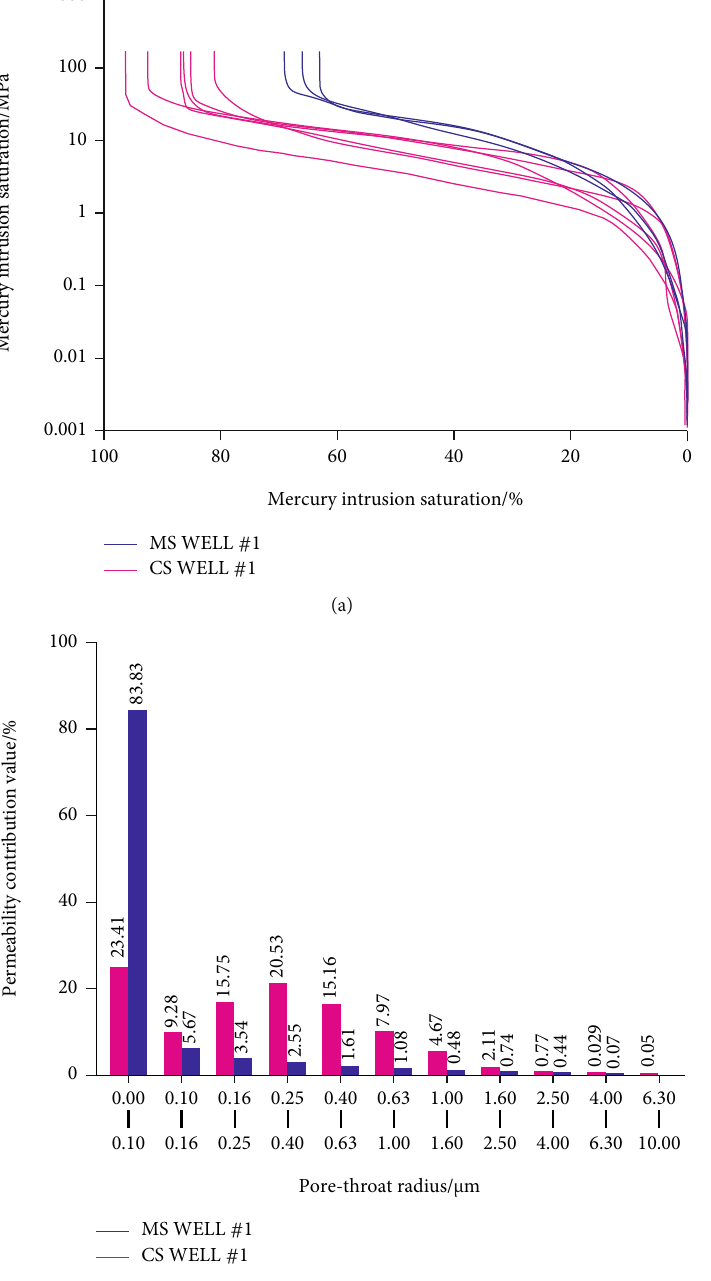
dn 4 member, and distribution of pore-throat radii. (a) HPMI curves of nine samples. 2